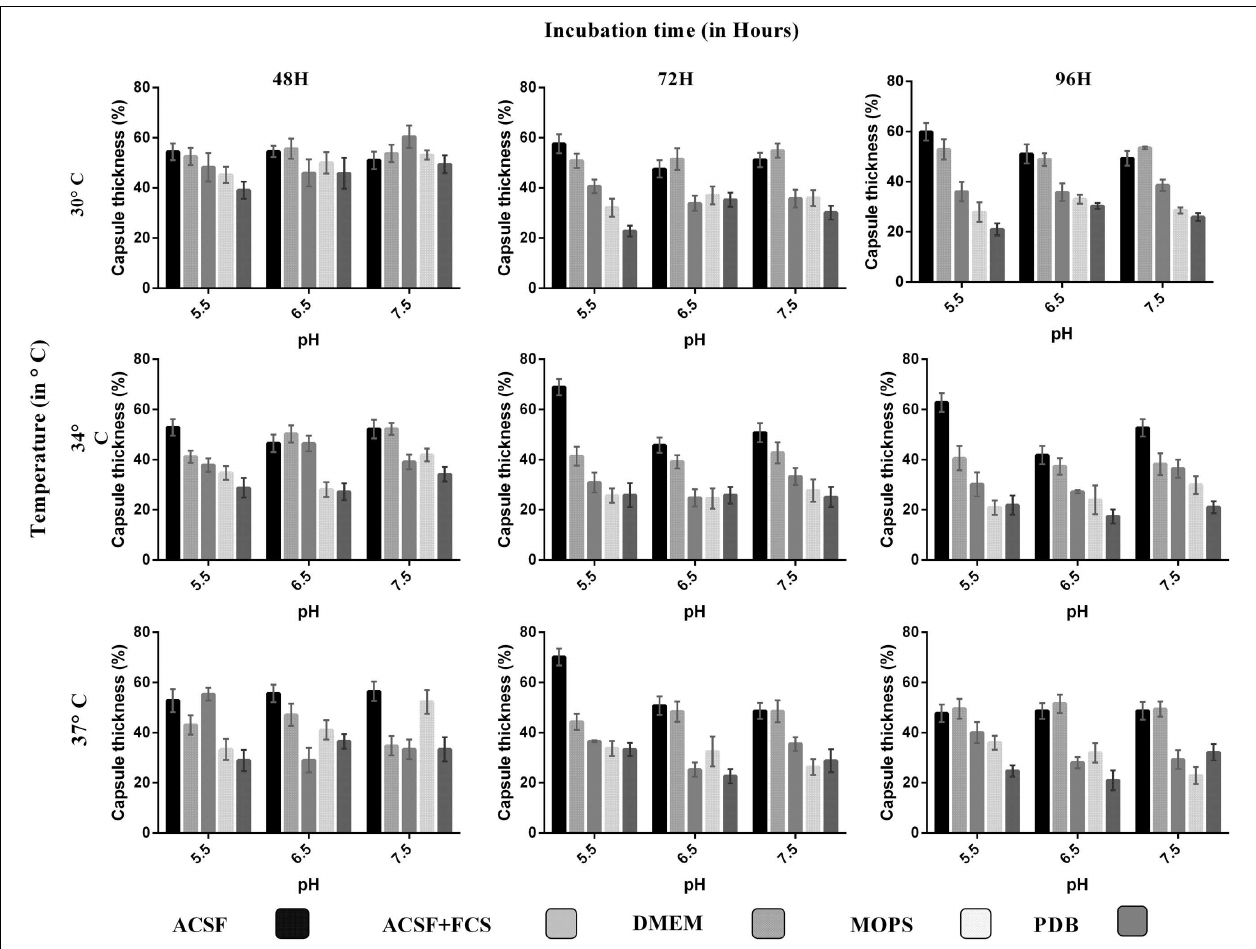
FIGURE 2 | Comparison of capsule growth in clinical C. neoformans in different media (ACSF, ACSF + FCS, DMEM, MOPS, and PDB) at various pH, temperature, and incubation period. The higher capsule induction was observed in ACSF media at pH 5.5, 37 ◦ C, 72 h, which is followed by ACSF 70%, ACSF + FCS 56%, DMEM 55%, MOPS 53%, and PDB 49%. The cell size, capsule size, and percentage of the capsule thickness for ≥ 8 cells per group are shown. Bars represent standard errors ( p <